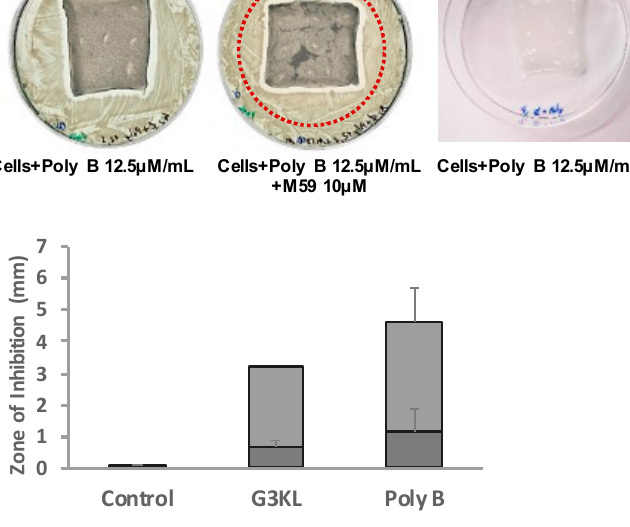
Figure 7. Antibacterial and anti-virulence properties of the final formulation of biological bandages on collagen matrix incorporating progenitor fibroblasts. The biological bandages were assembled with collagen matrix incorporating G3KL, M59, and progenitor fibroblasts. ( A ) The zone of growth inhibition surrounding the bandage (clear rectangle zone surrounding the matrix) shows the bactericidal effect of the dressing. The brown halo around dressings incorporating M59 (red dotted circle) shows the inhibition of pyocyanin expression. Only the formulating incorporating both G3KL and M59 shows both the inhibition zone and the inhibition of pyocyanin expression (absence of green color). ( B ) Images of matrices withdrawn from plates of panel ( A ). ( C ) Quantification of the zone of inhibition for bacterial growth. Dark grey: minimal inhibitory zone size, light grey: maximal inhibitory zone size.